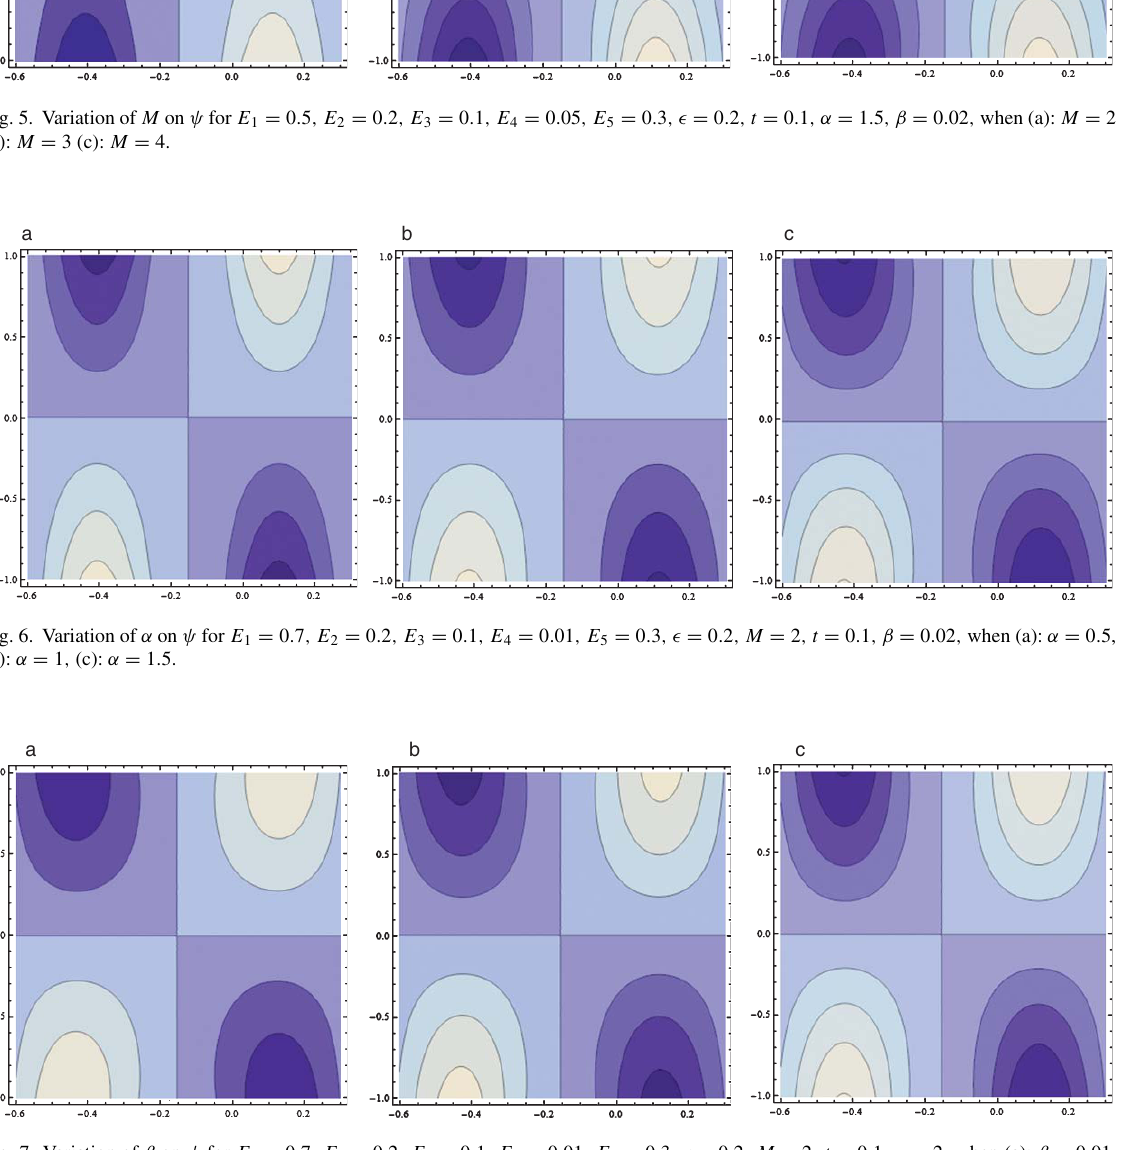
Fig. 7. Variation of β on ψ for E 1 = 0 . 7 , E 2 = 0 . 2 , E 3 = 0 . 1 , E 4 = 0 . 01 , E 5 = 0 . 3 , (cid:11) = 0 . 2 , M = 2 , t = 0 . 1 , α = 2 , when (a): β = 0 . 01, (b): β = 0 . 03 , (c): β = 0 .